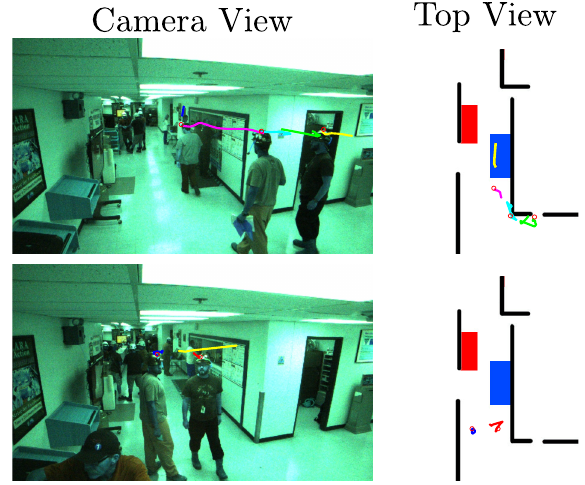
Figure 10. Tracking head in image space vs. tracking all points in joint